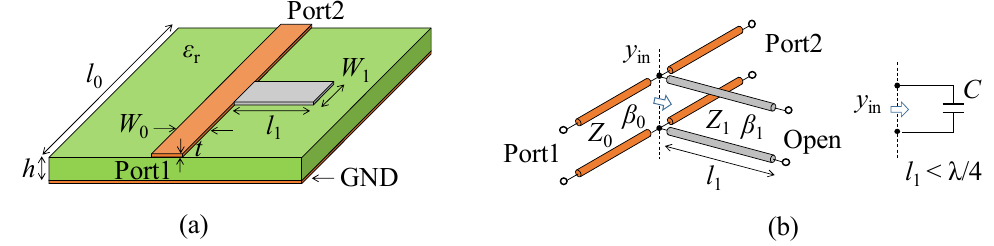
Figure 1. ( a ) Schematic view of a microstrip line (MSL) open-circuited stub. ( b ) Transmission line equivalent circuit of MSL open-circuited stub, and its input admittance when l 1 < λ /4.